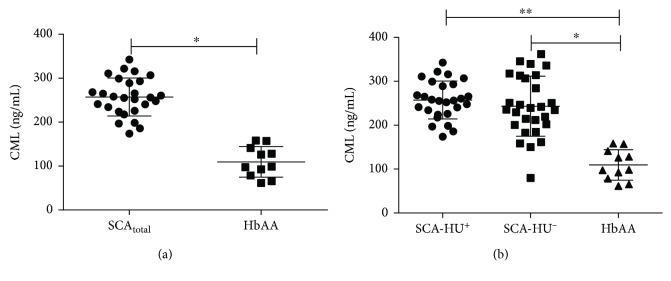
CML levels in individuals with SCA and HbAA. (a) Comparison of CML levels between SCAtotal and HbAA groups shows higher levels of CML in individuals with SCA compared to individuals with HbAA. (b) Comparison of CML levels between SCA-HU+, SCA-HU−, and HbAA groups shows higher levels of CML in both individuals with SCA-HU+ and SCA-HU− compared to individuals with HbAA.